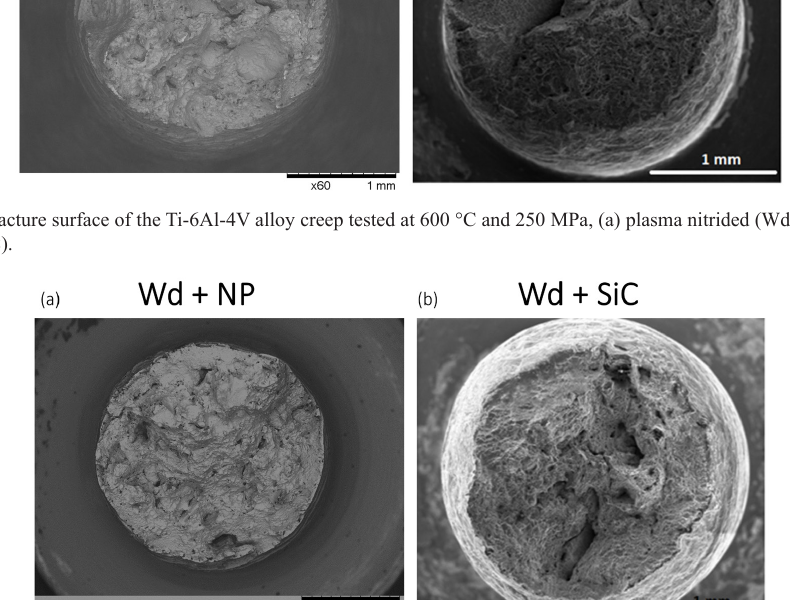
Figure 11. The fracture surface of the Ti-6Al-4V alloy creep tested at 600 °C and 319 MPa, (a) plasma nitrided (Wd + NP) and (b) SiC coated (Wd +